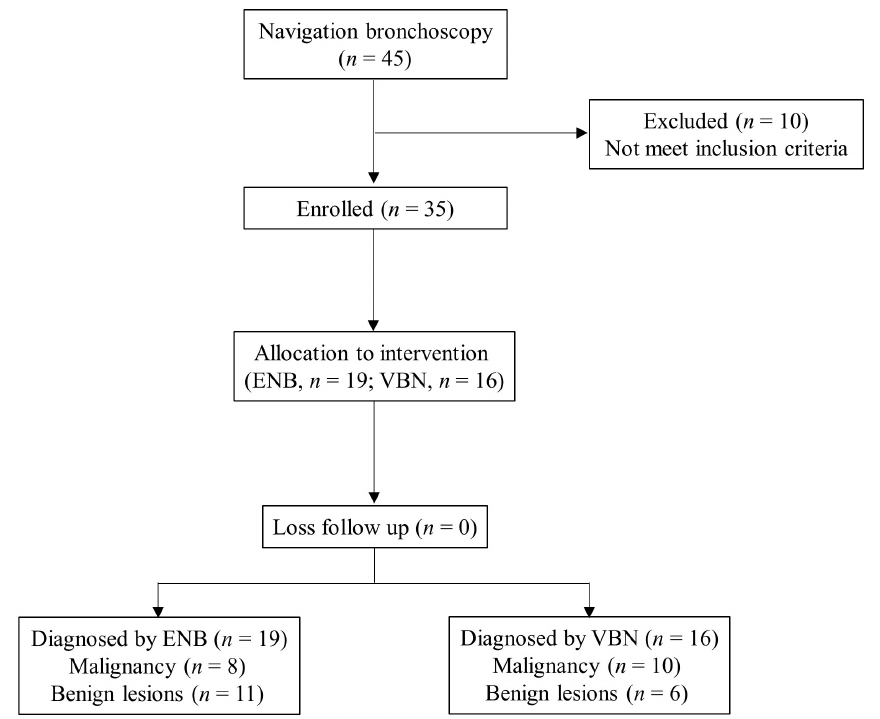
Figure 1. Flow diagram for the navigation bronchoscopy cases and